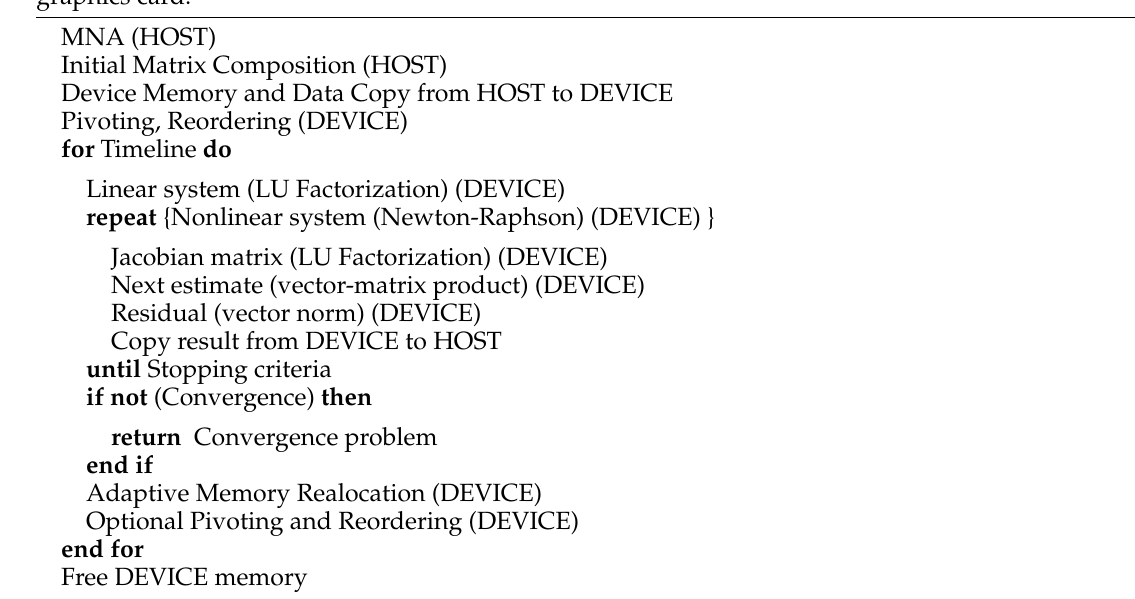
Algorithm 2 Transient analysis process using CUDA parallel calculation of LU factorization on a graphics